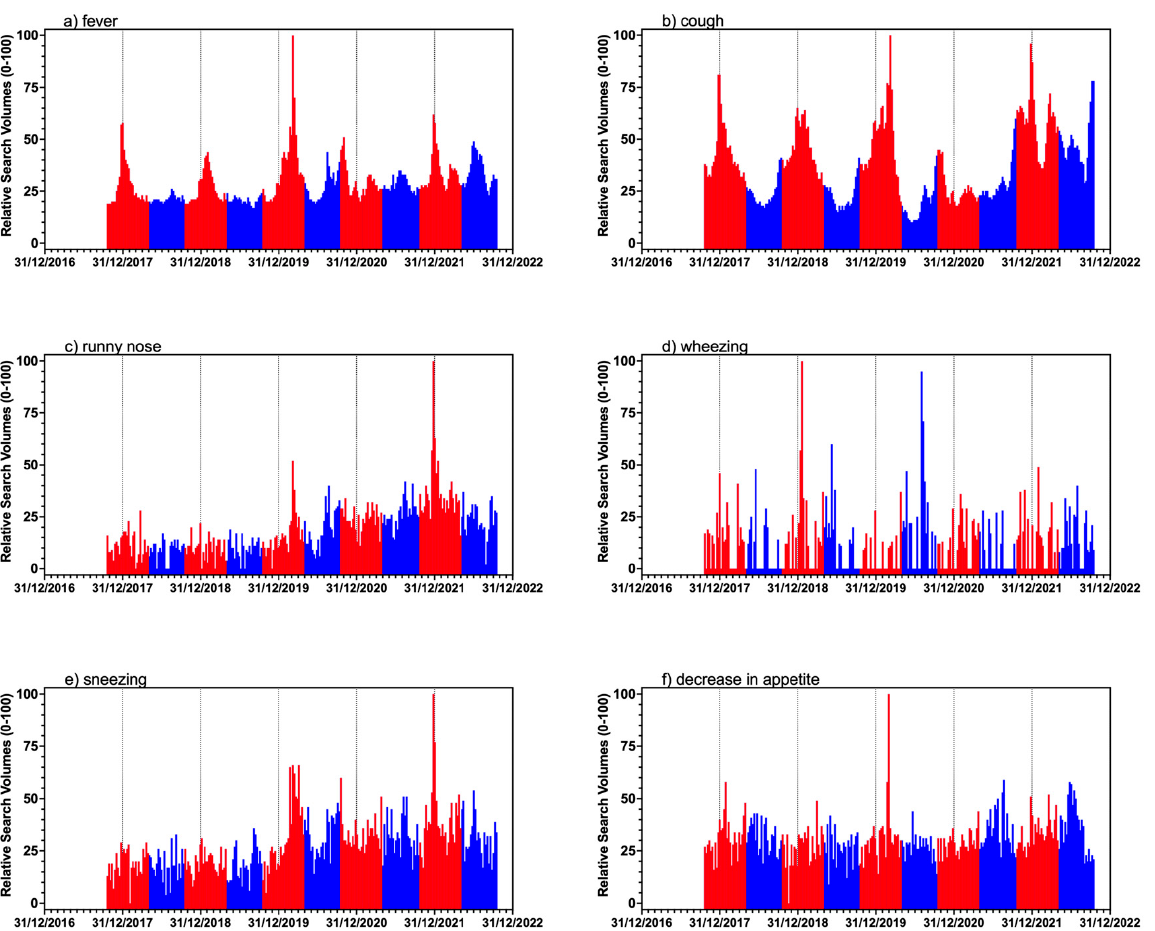
Figure A2. Seasonal trend of research terms for symptoms associated with diagnoses of RSV included in the analyses: ( a ) fever; ( b ) cough; ( c ) runny nose; ( d ) wheezing; ( e ) sneezing; ( f ) decrease in appetite. Dotted lines represent 31 December of the correspondent calendar year. Red lines represent relative search volumes estimates for weeks included in the seasonal epidemiological surveillance for influenza-like illnesses, while blue lines represent weeks not included.